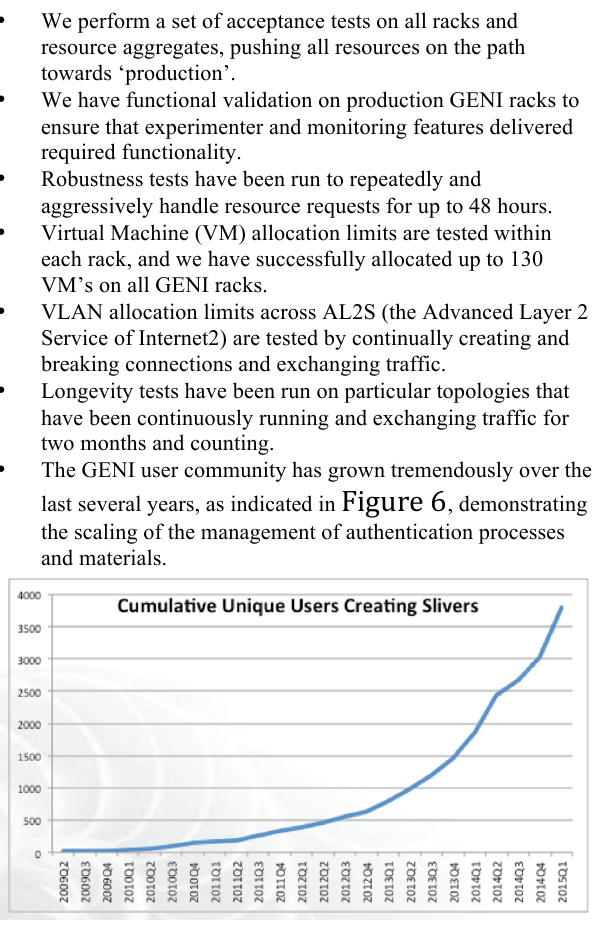
Figure 6. Growth of GENI users and corresponding identification and authentication/authorization mechanisms since